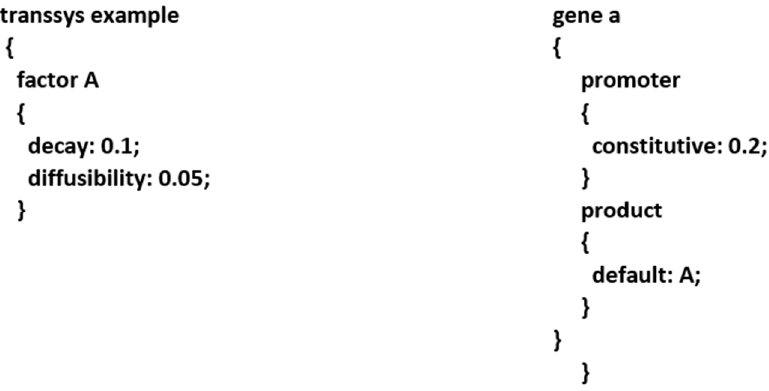
Figure 5. Example transsys programs comprising one factor, A, and one gene, a. More details modelling GRN using transsys are available on http://www.transsys.net, accessed on 1 May 2020.